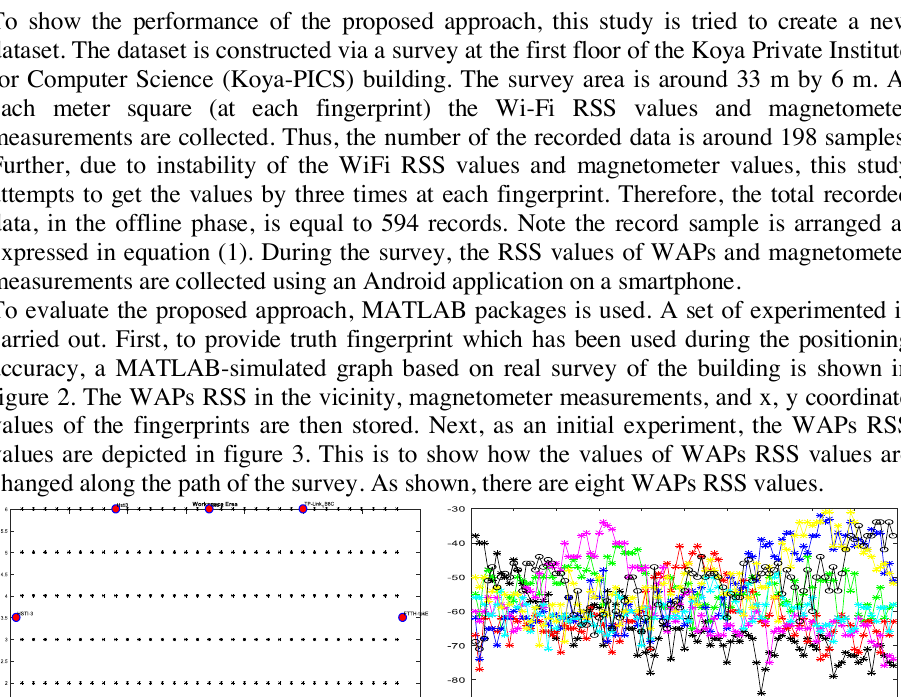
Fig. 2. The eight WAPs RSS values along the survey path.